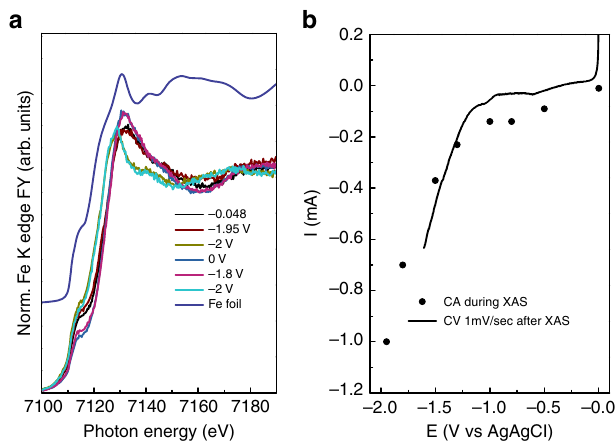
Fig. 9 FY-mode Fe K edge XANES spectra measured in quick mode for the Fe/O-C (Fe loading 1 wt. %) at different potential. a Edge normalized, merged XANES spectra measured in 0.05 M KHCO 3 at different potential as indicated and b corresponding instantaneous current measured at constant potential (CA) as function of the potential